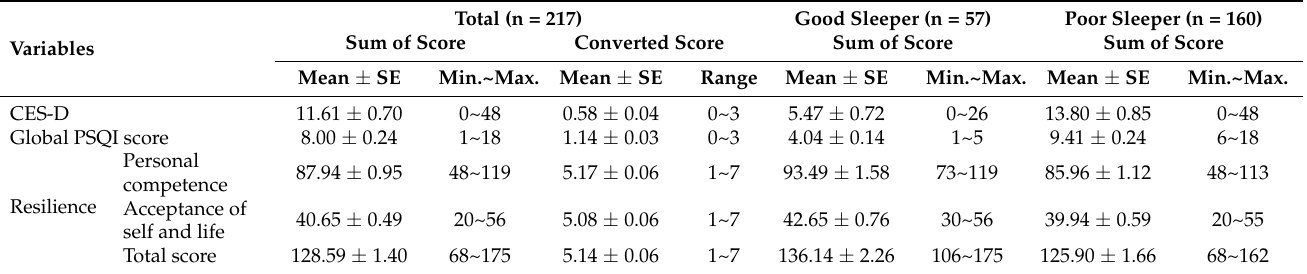
Table 2. Descriptive Statistics of the Variables (n =